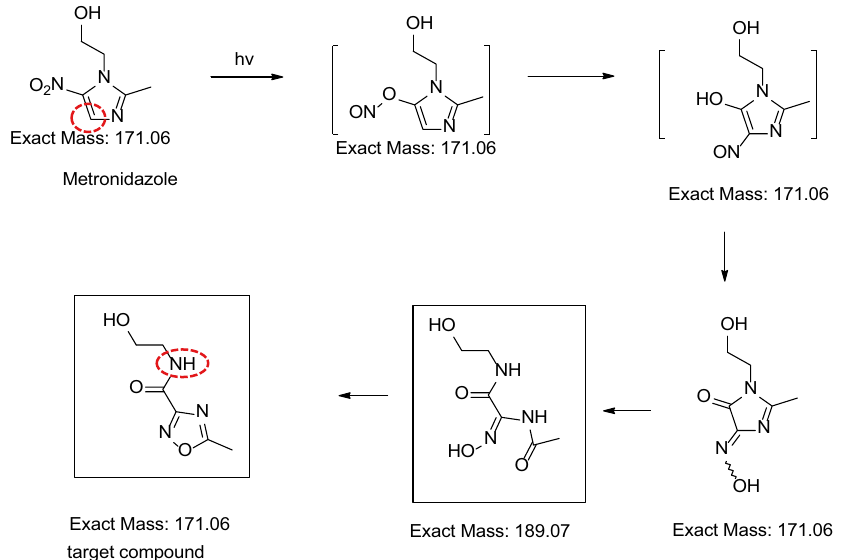
Figure 1. Proposed photolytic rearrangement pathway of metronidazole to N -(2-hydroxyethyl)-5-methyl-l,2,4- oxadiazole-3-carboxamide 1–3